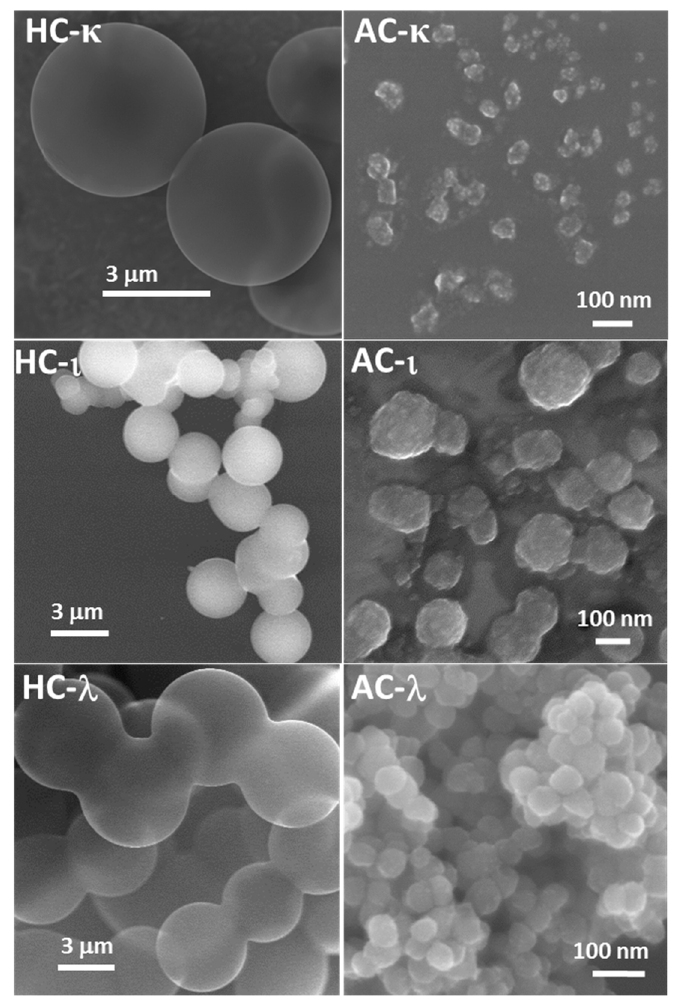
Figure 1. Electron micrographs of carrageenan-derived hydrochars ( left ) and activated carbons ( right ).